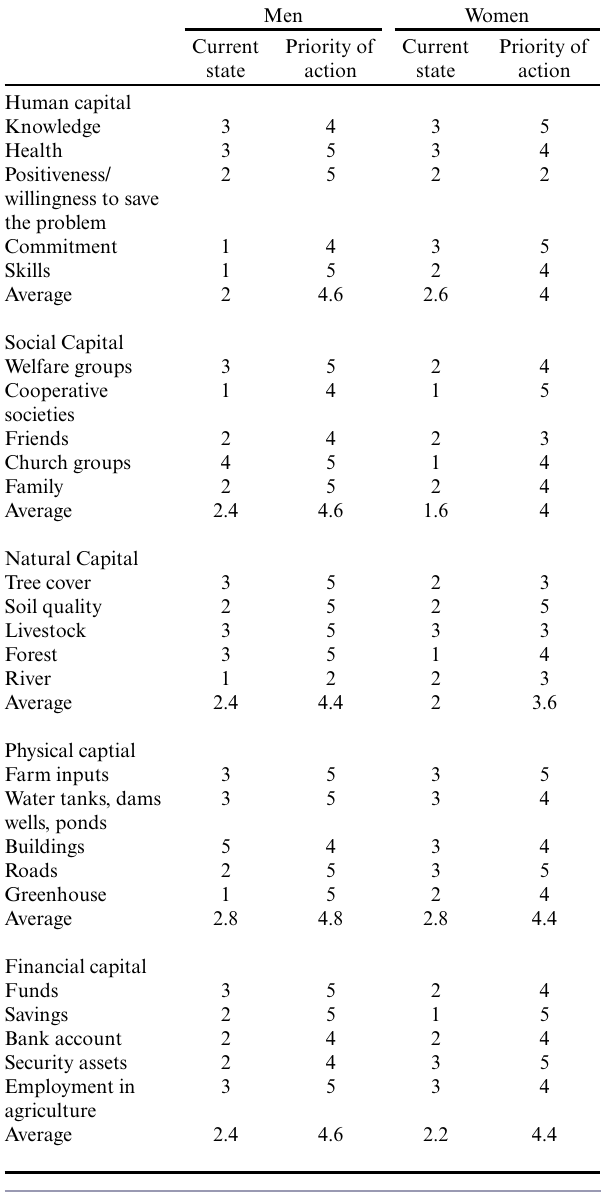
Table 4 . Example for the rating of adaptive capacity conducted for drought in the lower lying areas of the watershed. Ratings were conducted on a scale of 1(very bad current state/very low priority of action to improve the current state of indicators) to 5 (very good current state/very high priority of action) and broadly followed the approach outlined by Roth et al. (2010) and Brown et al.